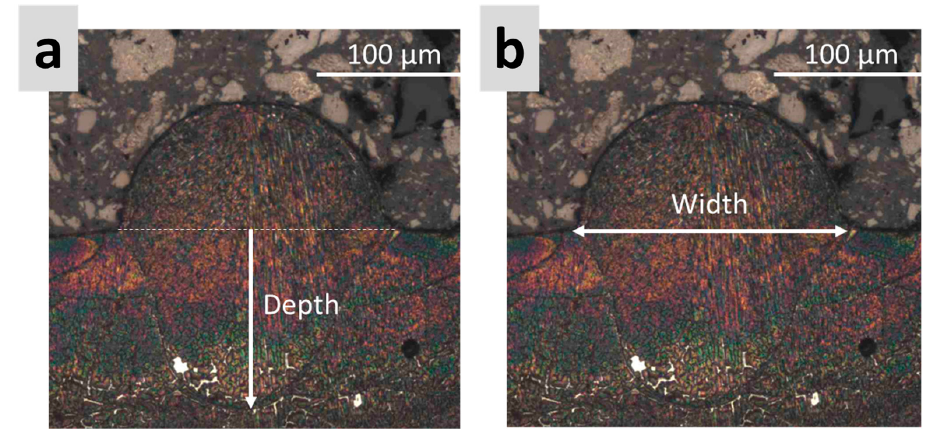
Figure 7. Sample’s microstructure at 100x magnification.